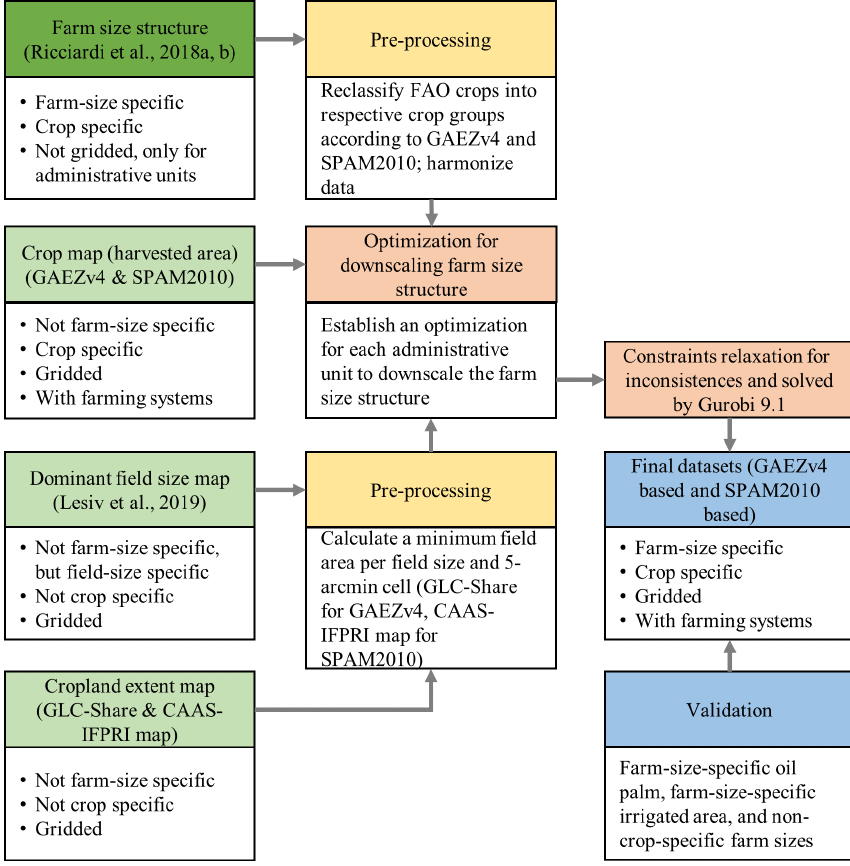
consistencies with the underlying administrative unit farm size and grid cell level